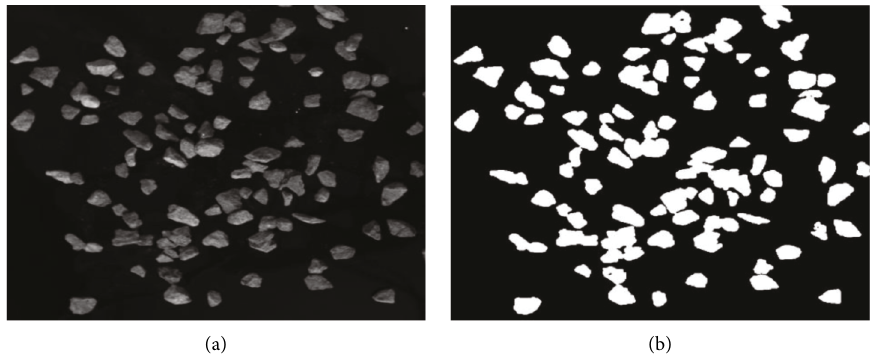
Figure 16: 2.36-4.75mm original image and inspection image.